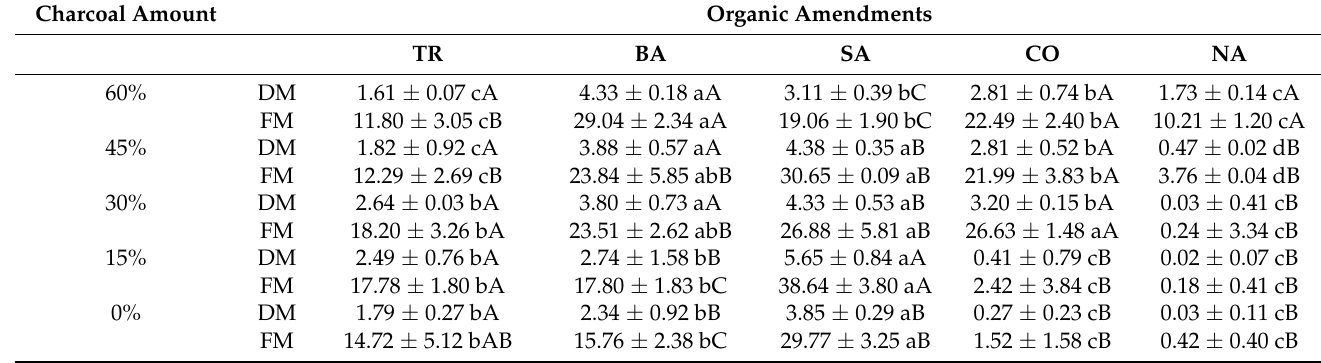
Table 2. Dry matter (DM) and fresh matter (FM) yields (g plant − 1 ) of Giant of Italy parsley grown on organic amendments made from mixtures of composts and charcoal. Composts were made from poultry industry wastes and tree trimmings (TR), sugarcane bagasse (BA), sawdust (SA), cotton waste (CO), and Napier grass (NA). Different lowercase letters in the rows indicate statistical differences between the means for organic amendments; different capital letters in the columns indicate statistical differences between the means for the amount of charcoal ( p ≤ 0.05; Scott-Knott test). Charcoal Amount Organic